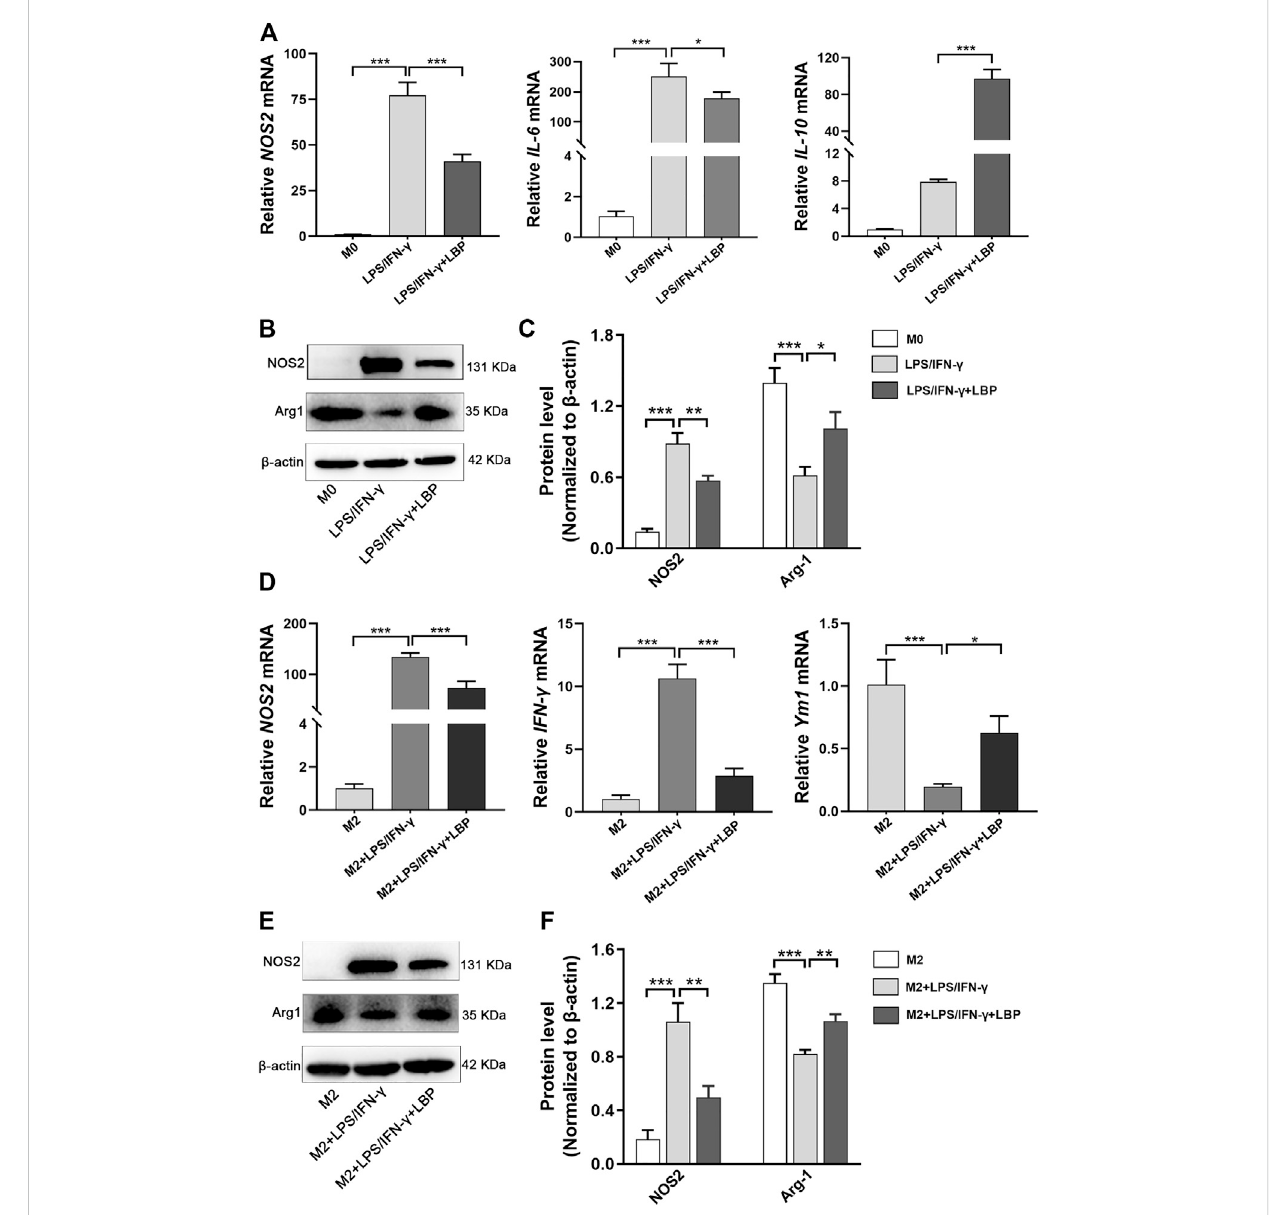
FIGURE 5 The in fl uence ofLBPon theexpression ofthe related genesinvolving thepolarization ofmacrophage was tested by q PCR and Westernblot. (A) The q PCR results of NOS2, IL-6, and IL-10 in the M0, LPS/IFN- γ , and LPS/IFN- γ + LBP groups. (B) Western blot results of NOS2, Arg-1, and ß -actin in the M0, LPS/IFN- γ ,andLPS/IFN- γ +LBPgroups. (C) Thequanti fi cationoftheproteinbandsofNOS2andArg-1inFigure 5B. (D) The q PCRresultsofNOS2,IFN- γ , andYm1intheM2,M2+LPS/IFN- γ ,andM2+LPS/IFN- γ +LBPgroups. (E) WesternblotresultsofNOS2,Arg-1,and ß -actinintheM2,M2+LPS/IFN- γ and M2 + LPS/IFN- γ + LBP groups. (F) The quanti fi cation of the protein bands of NOS2 and Arg-1 in Figure 5E. Signi fi cant differences are indicated as * p < 0.05, ** p < 0.01, *** p <